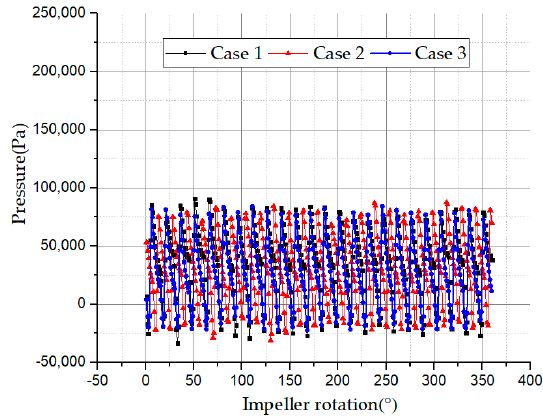
Figure 10. Static pressure distribution in the side channel.